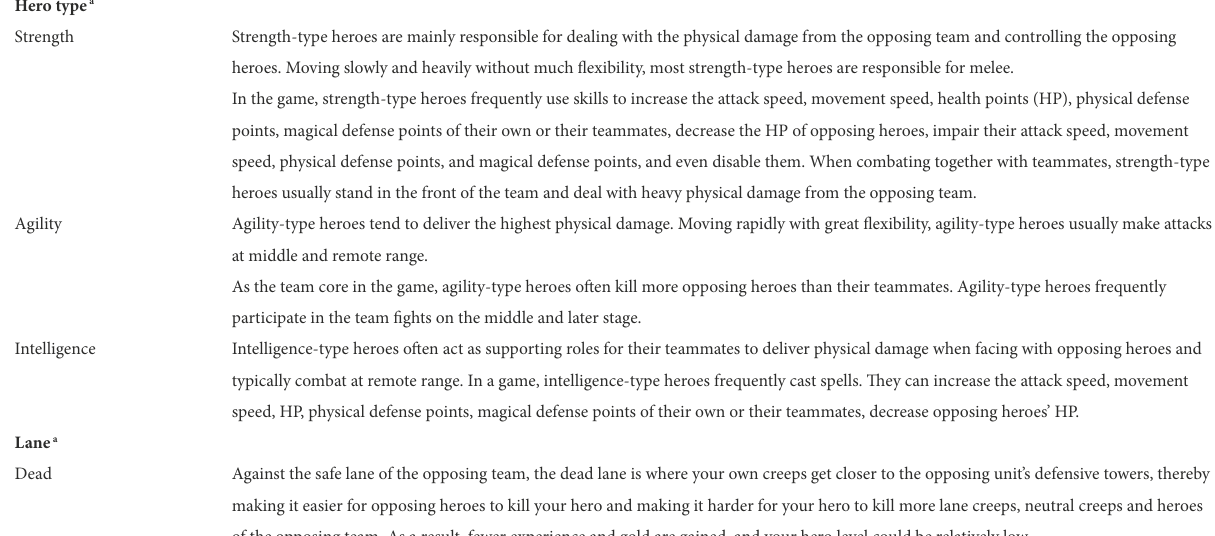
TABLE 2 Confounding factors. Confounding factor Common gaming behavior Hero type